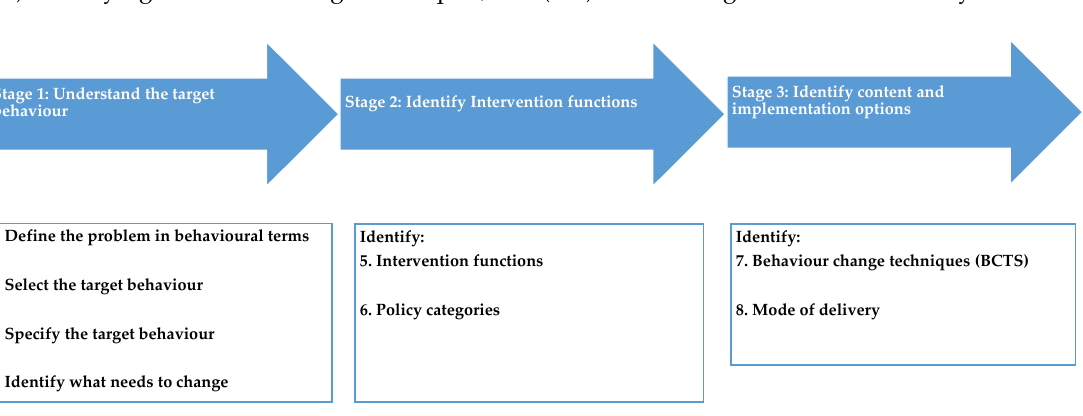
Figure 2. The BCW Intervention design process (Michie, Atkins & West, 2014 [22]).